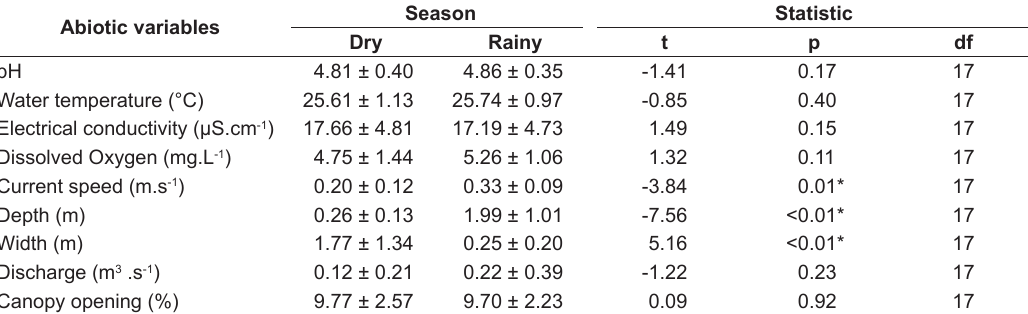
Table 1. Comparison of the abiotic variables recorded between the dry (07-09/2013) and rainy (04-05/2014) seasons . Abiotic